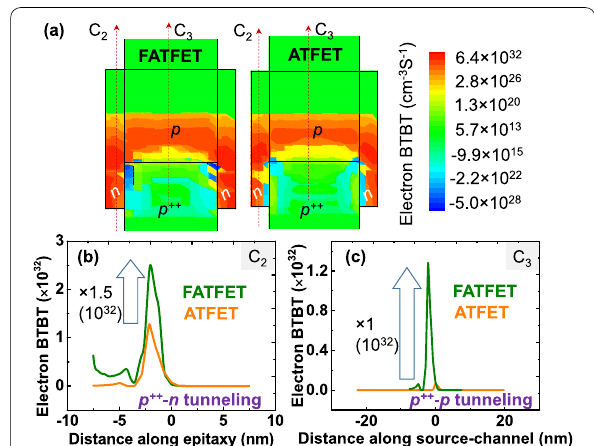
Fig. 4 a Electron BTBT profile of devices FATFET and ATFET with high tunneling in FATFET (closer to p ++ - n - p junctions). Plots of ( b ) vertical tunneling ( p ++ – p ) and c lateral tunneling along the cut-lines C 2 and C 3 in the explored devices. Due to gradual decrease in tunneling length (as per Fig. 3), FATFET exhibits stronger vertical and lateral tunneling than ATFET